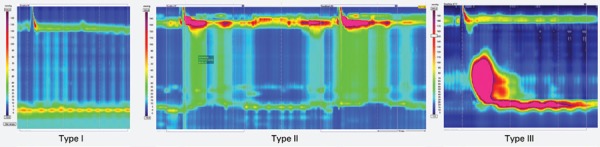
Achalasia types